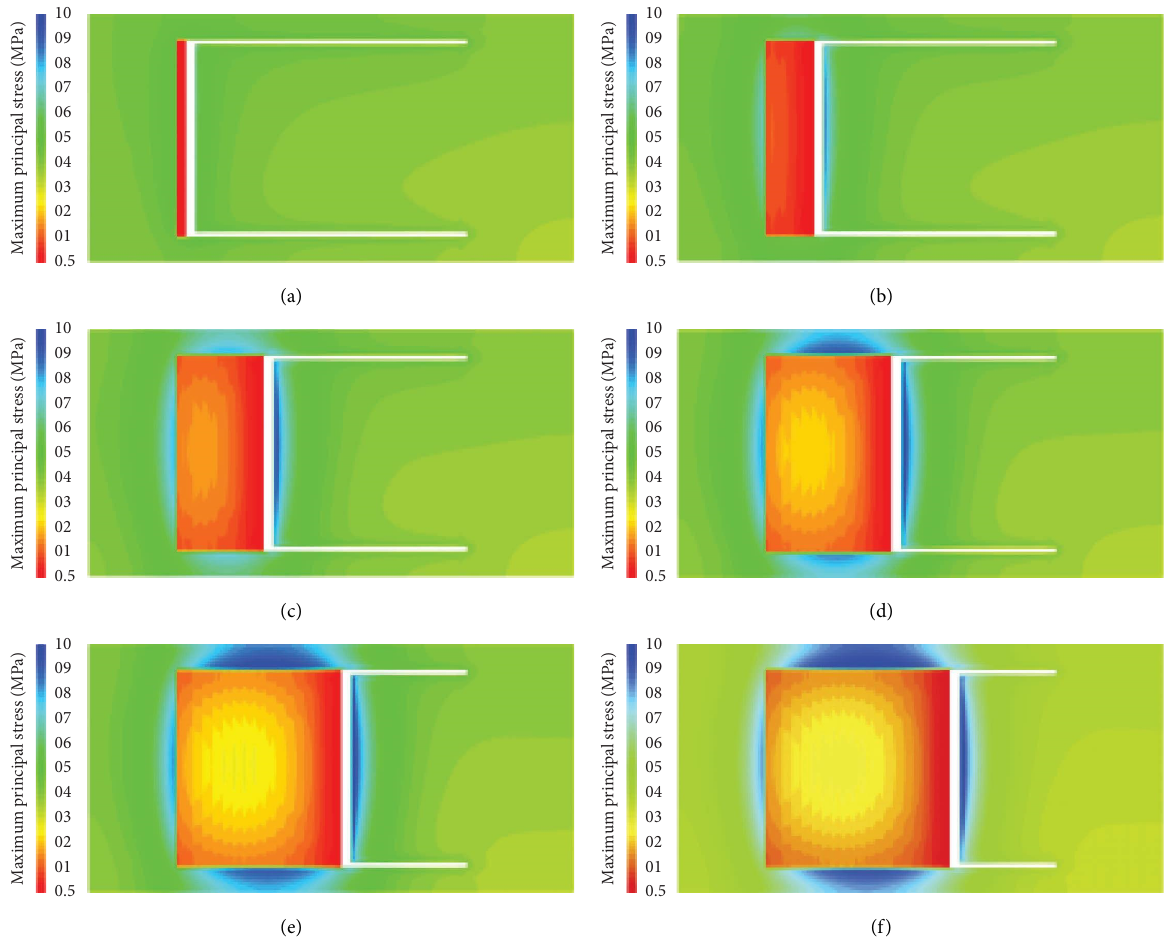
Figure 3: Distribution characteristics of maximum principal stress under diferent propulsion distances: (a) advance 32m, (b) advance 96m, (c) advance 160m, (d) advance 224m, (e) advance 288m, and (f) advance